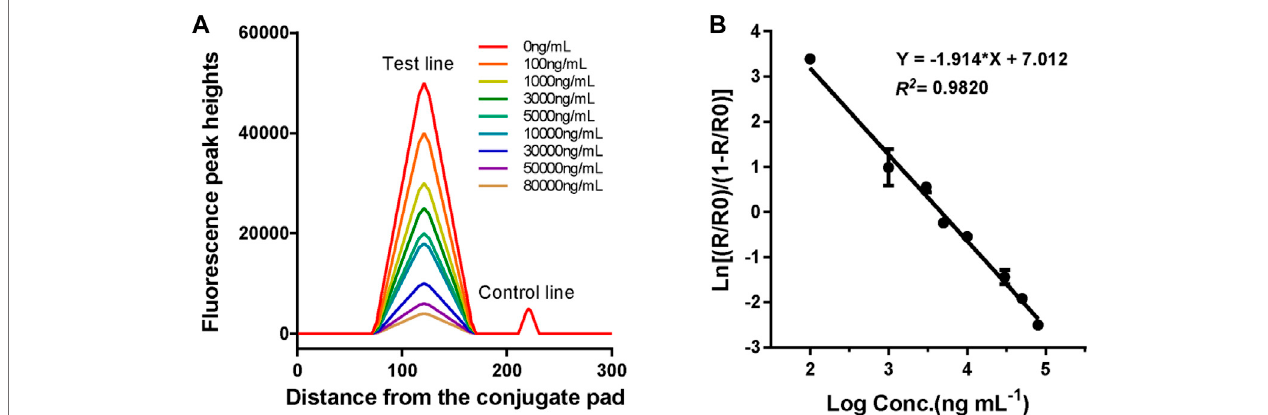
FIGURE 5 | Fluorescence peak readout curve and standard curve of CN-EUs-based LFIA strips for VAN. (A) Fluorescence peak heights readout curve for VAN at concentrations of 0 – 80,000 ng*ml − 1 . (B) Standard curve of CN-EUs-based LFIA strips for VAN was obtained for calibration samples from 0 to 80,000 ng*ml − 1 . A logit- log plot was obtained from the computation formula: ln (Y) (cid:1) − 1.914*log(X)+7.012, Y (cid:1) (Rx/R0)/(1-Rx/R0).